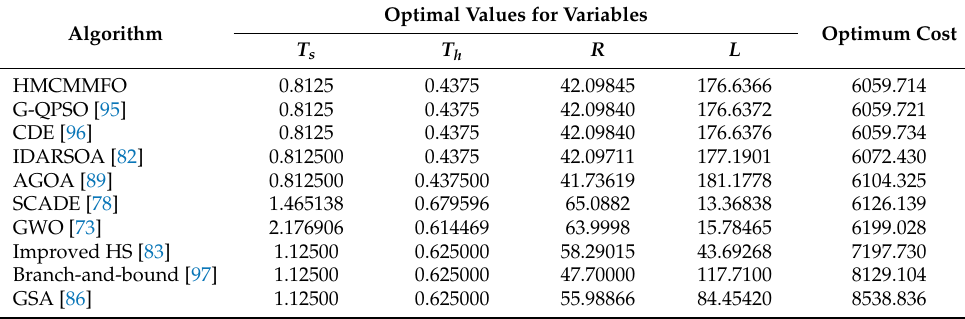
Table 11. Comparison results of pressure-vessel-design